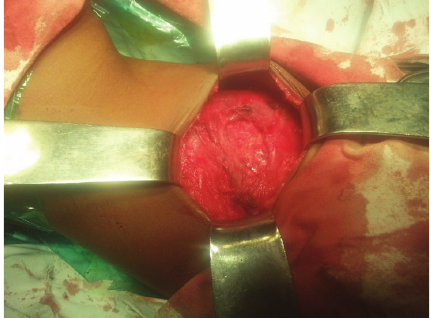
Figure 1: Left-sided congenital lumbar hernia.